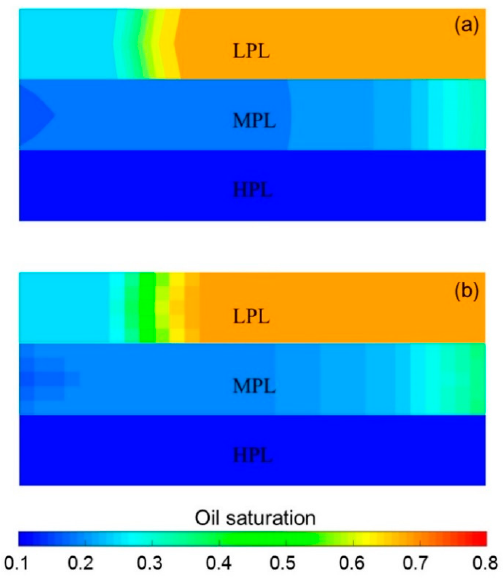
Figure 14. Oil saturation distributions of each layer after injection of 0.64 PV polymer solution obtained with ( a ) the saturation detector and ( b ) the designed simulator.